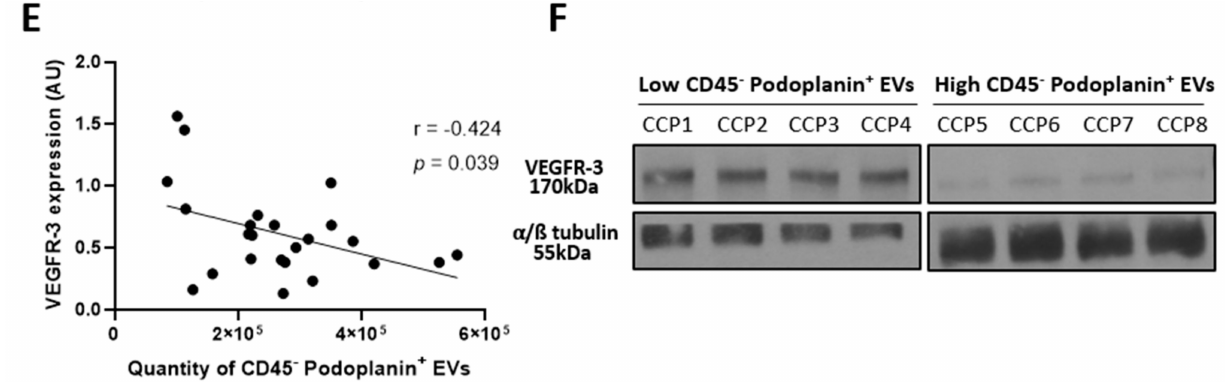
Figure 6. Secretion of lymphatic endothelial cells derived extracellular vesicles is a marker of impaired integrity. ( A ) Treated aHDLEC (convalescent plasma for 4 h and cytokines for 20 h) labeled by the MitoSOX TM Red probe and correlated with the quantity of EVs shed by the lymphatic endothelial cells. ( B , C ) Cells in sub-G 0 /G 1 ( B ) and G 2 /M ( C ) phases of the cell cycle, determined by cell cycle analysis using PI, were correlated to the quantity of EVs secreted by the lymphatic endothelium. ( D , E ). Treated aHDLEC were harvested and expression of FLT4 was assessed by RT- qPCR ( D ) and immunoblot ( E ) followed by a normalization onto the expression of ACTB or α /ß tubulin, respectively. The measured expression of VEGFR-3 was then correlated with the quantity of EVs secreted by the endothelium. ( F ) Immunoblot analysis for VEGFR-3 and the loading control α /ß tubulin. The left panel represents aHDLEC secreting low quantities of CD45 − podoplanin + EVs (less than 120,000 EVs) following incubation with CCP, and the right represents aHDLEC secreting high quantities of CD45 − podoplanin + EVs (more than 380,000 EVs). Significance was determined by a Pearson correlation and p < 0.05 was considered significant. EVs, extracellular vesicles; PI, propidium iodide; CCP, COVID-19 convalescent plasma; VEGFR-3, vascular endothelial growth factor receptor 3; FLT4, gene coding for VEGFR-3; aHDLEC, adult human dermal lymphatic endothelial cells; AU, arbitrary